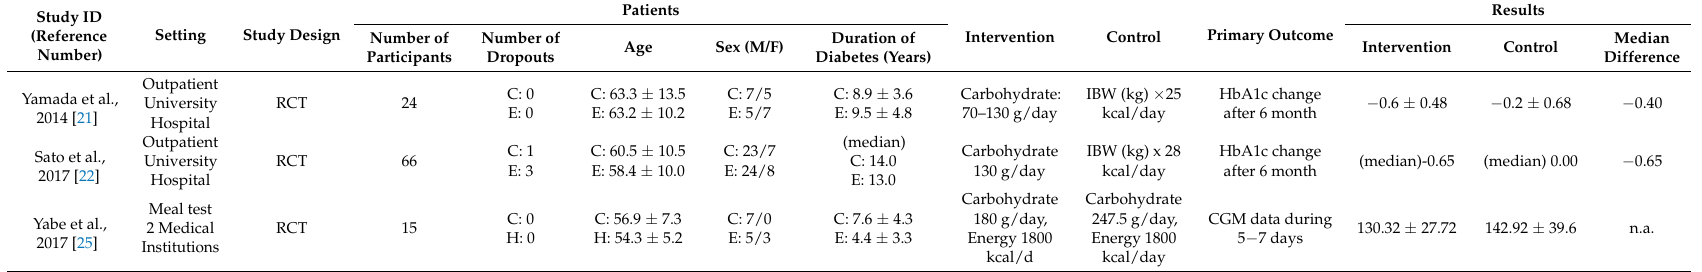
Table 1. Summary table of studies on carbohydrate restriction diet (including energy restriction studies as control group [21,22]).